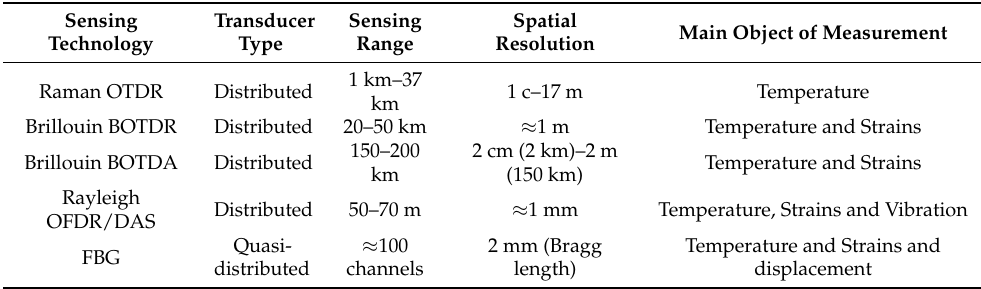
Table 2. Performance differences between the various distributed sensing techniques [1].